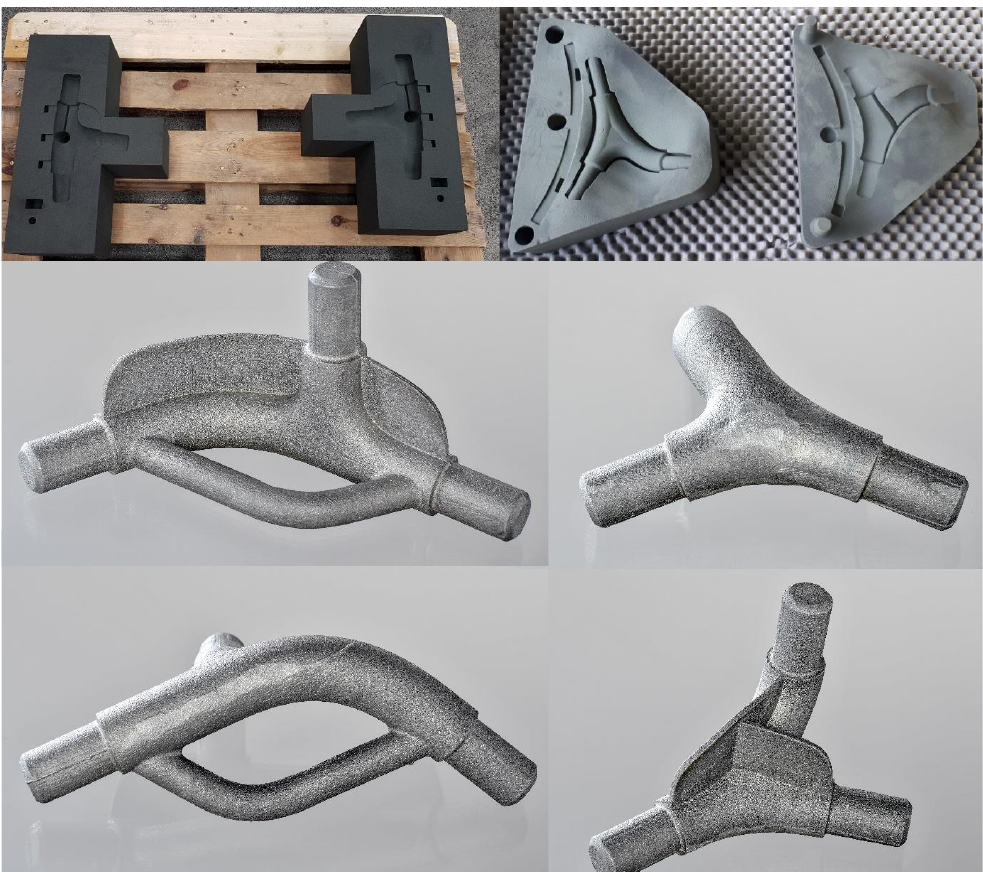
Figure 2. The upper row shows two printed mold parts fort manufacturing the casting knots. The molds are mirrored to be used in the left and right side of the vehicle body structure. The lower rows present two sample functionally integrated casted knots for joining the tubes of the vehicle body. The passenger can use the additional strut (left knot) as a handle. The reinforcements of the left knot are the fixing points for the roof cladding and windscreen. The right knot joins the tubes at the cars